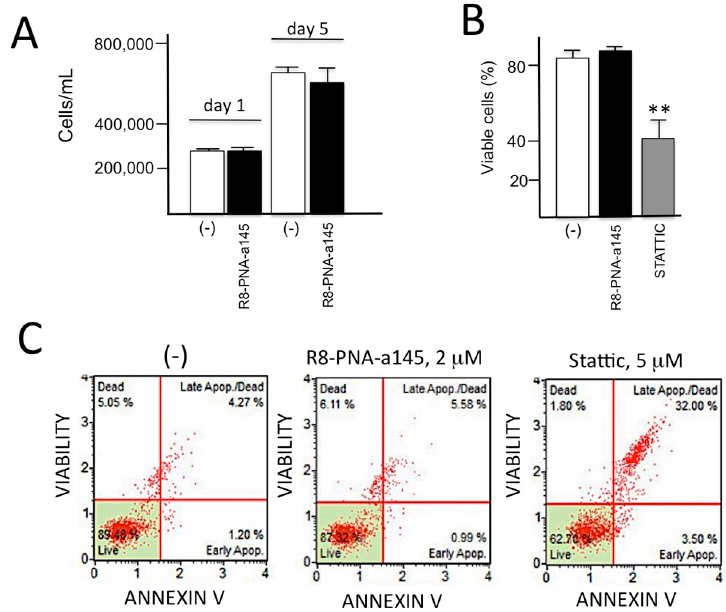
Figure 5. Effects of R8-PNA-a145 on cell growth, vitality and apoptosis. ( A ) Calu-3 cells were cultured in the absence or in the presence of R8-PNA-a145 different days and the cell number/mL determined; ( B , C ) Effects of R8-PNA-a145 on vitality ( B ) and apoptosis ( C ) of Calu-3 cells. Vitality was determined by trypan blue analysis of dead cells; apoptosis by the Annexin V & Dead Cell Kit (Millipore Corporation). Results in panels ( A , B ) represent the average ± S.D. of three independent experiments. ** = p < 0.01.